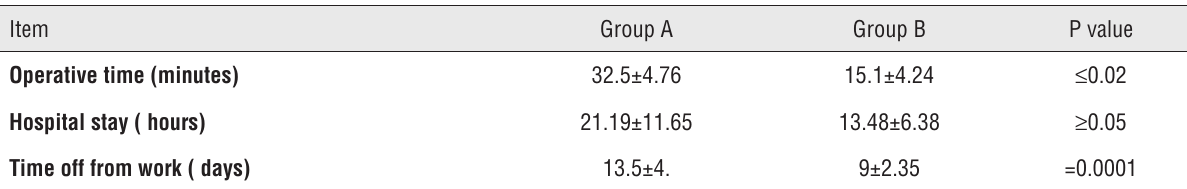
Table1 - Mean operative time, hospital stay and time off from work in both groups. Item Group A Group